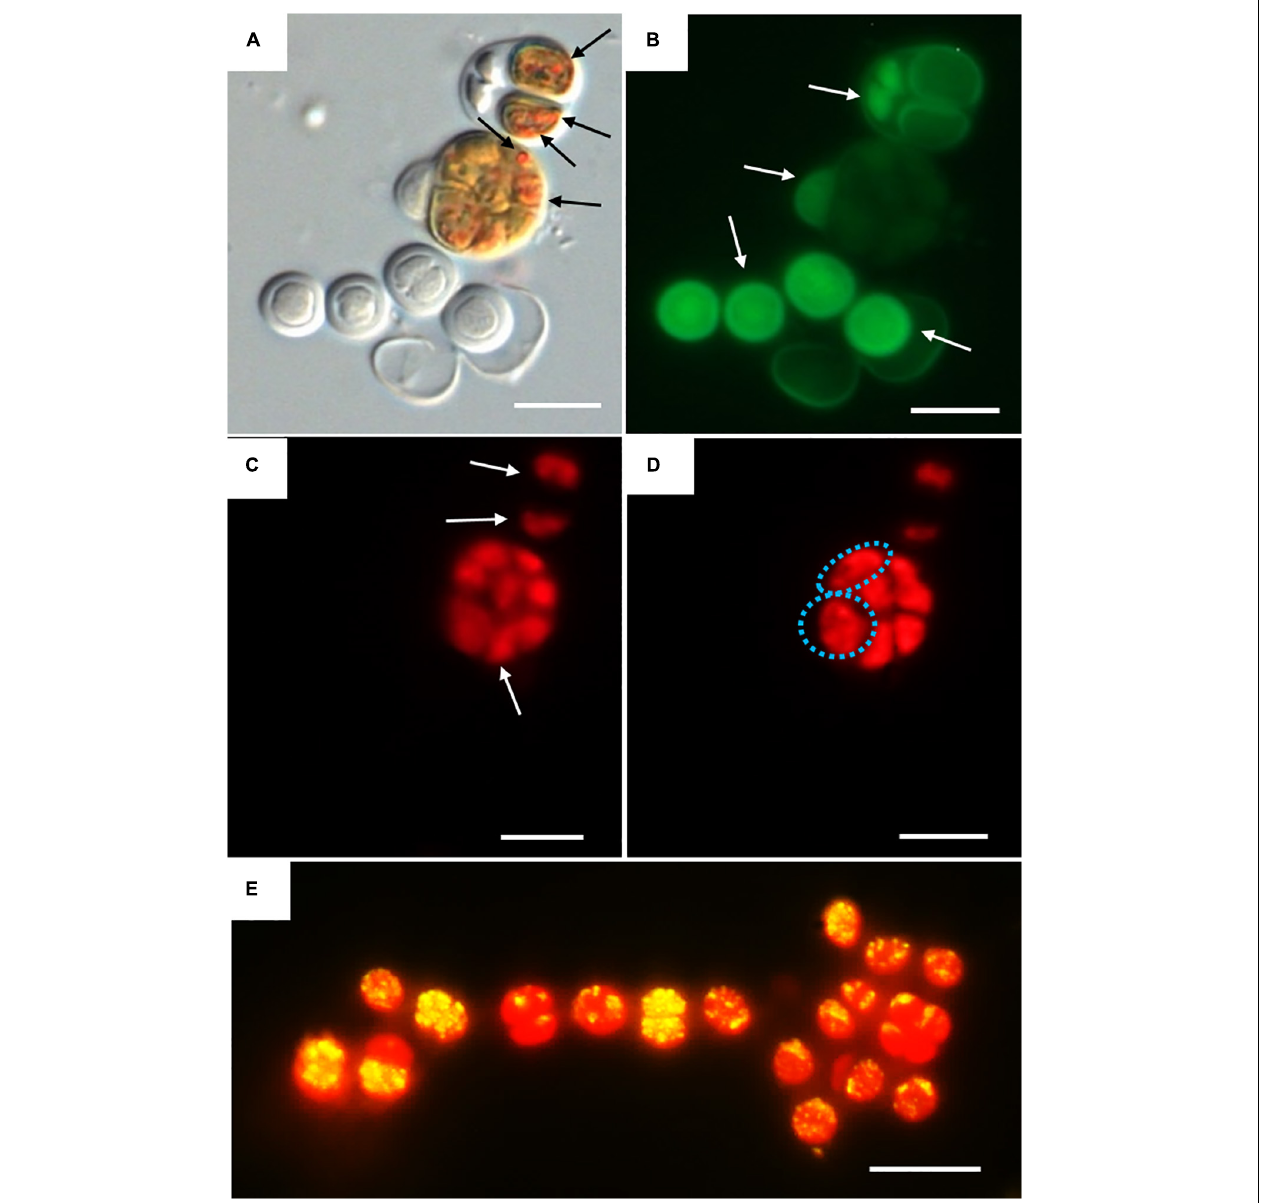
FIGURE 4 | DIC and fluorescence microscopy showing examples of metabolic activity in UAM816 cells after 6 days of irradiation with UVR + PAR. (A) DIC microscopy image with orange CTF crystals in metabolically active cells (black arrows). (B) eGFP filter set fluorescence image revealing unviable cells (GF+) (white arrows). (C) HE rhodamine filter set fluorescence image revealing cells with phycobiliproteins and chlorophyll a autofluorescence (white arrows) (PCHL+). (D) HE rhodamine filter set fluorescence image of cells with phycobiliproteins and chlorophyll a autofluorescence and weak CTF fluorescence (granulose red fluorescence) (blue dotted cells) (PCHL+/CTC+). (E) HE rhodamine filter set fluorescence image of UAM816 cells after 3 days of under UVR + PAR. Cells with phycobiliproteins and chlorophyll a red autofluorescence plus a yellow signal indicating strong metabolic activity (PCHL+/CTC+). Scale bars = 10 µ